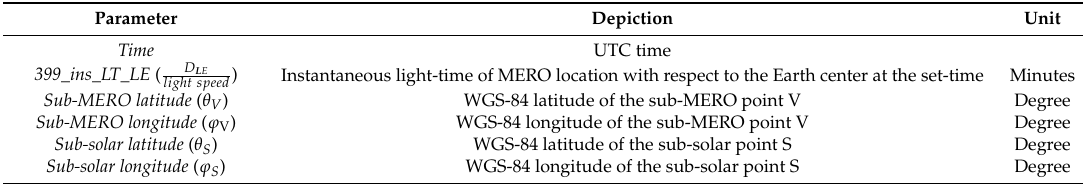
Figure 4. A sketch to illustrate the geometry of a MERO’s sight line towards a grid node in the MERO-viewed area at the Earth TOA. Table 1. The JPL Horizons System generated parameters used in this study.